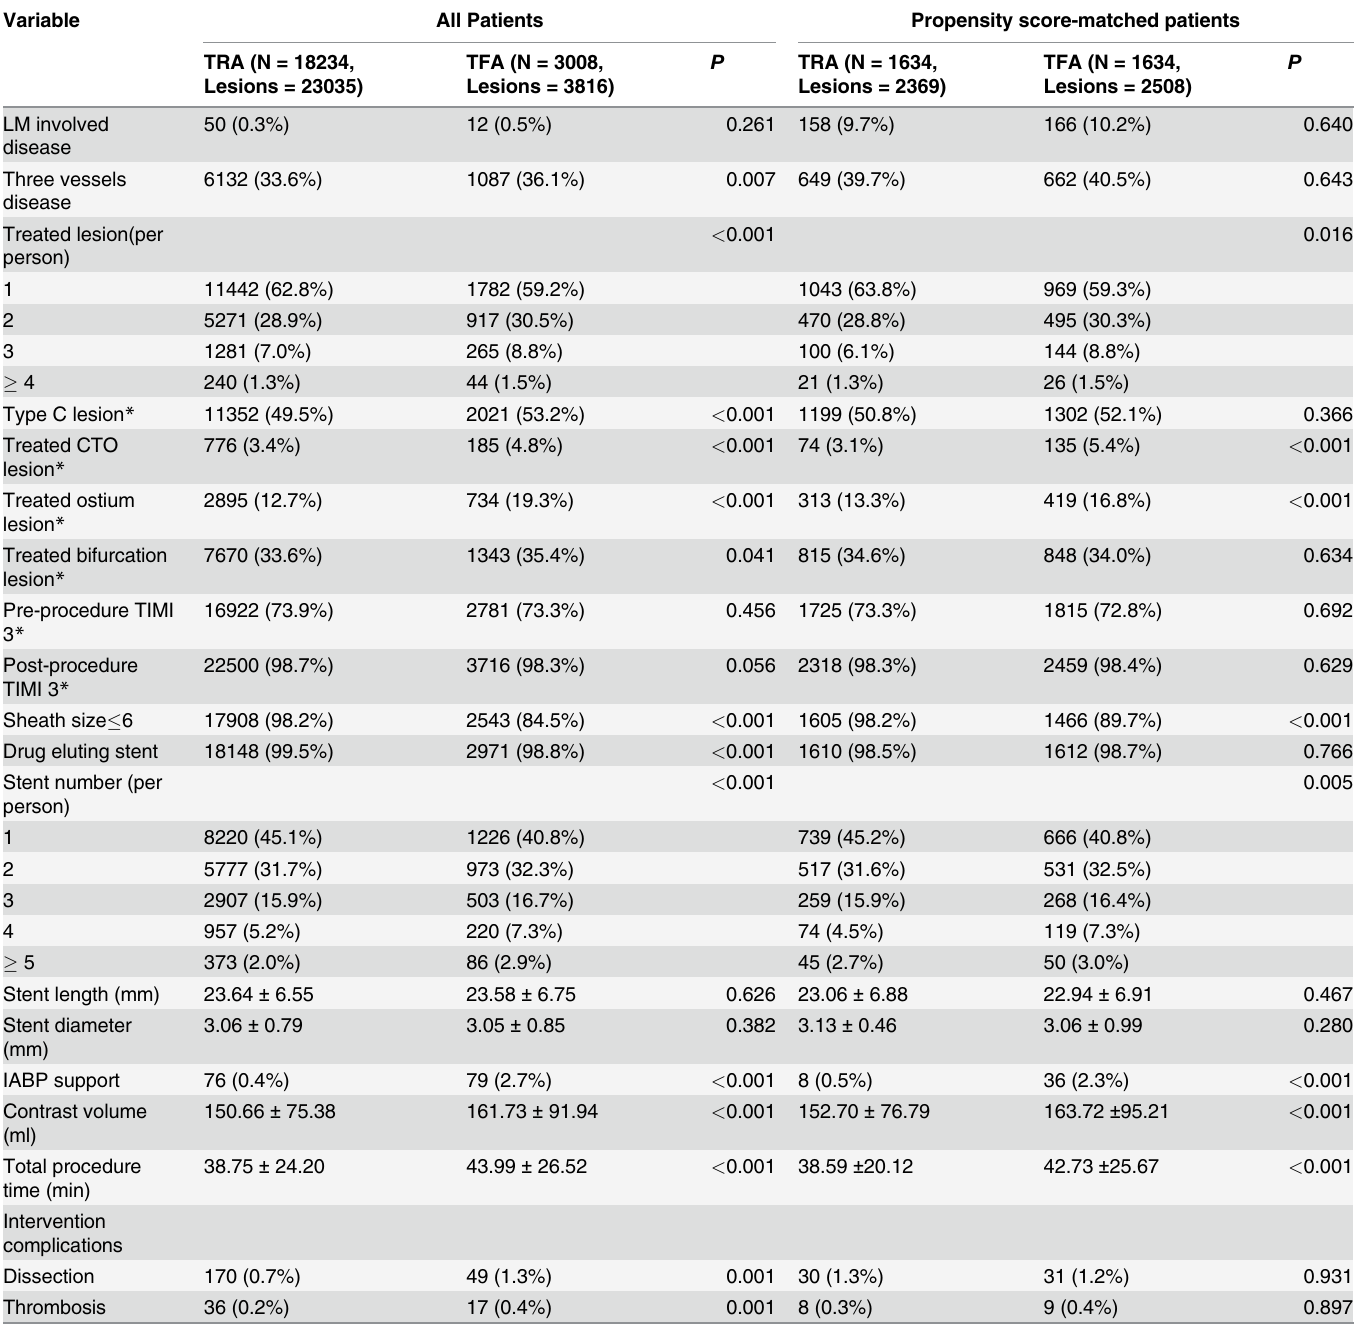
Table 2. Angiographic characteristics and procedure